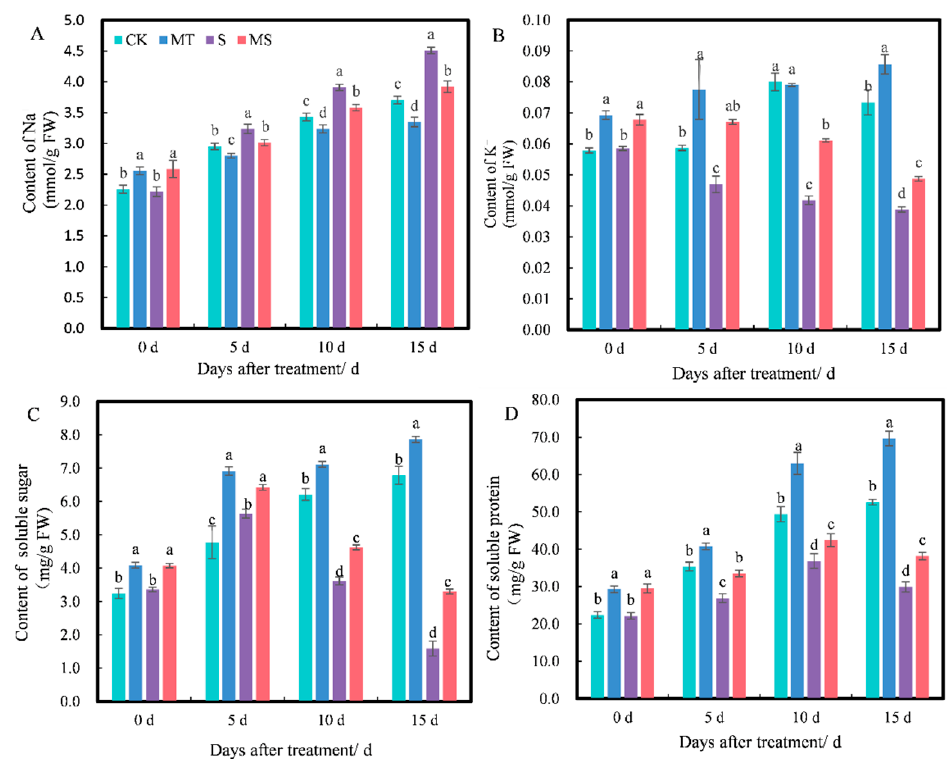
Figure 4. Effects of exogenous melatonin on Na + , K + , soluble sugar and soluble protein content of cotton seedling roots under salt stress: ( A ) Na + ; ( B ) K + ; ( C ) soluble sugar; ( D ) soluble protein. Different lowercase letters indicate significant differences among treatments at the same timepoint ( p < 0.05). CK, control treatment; MT, melatonin treatment; S, NaCl treatment; MS, combined melatonin and NaCl treatment.